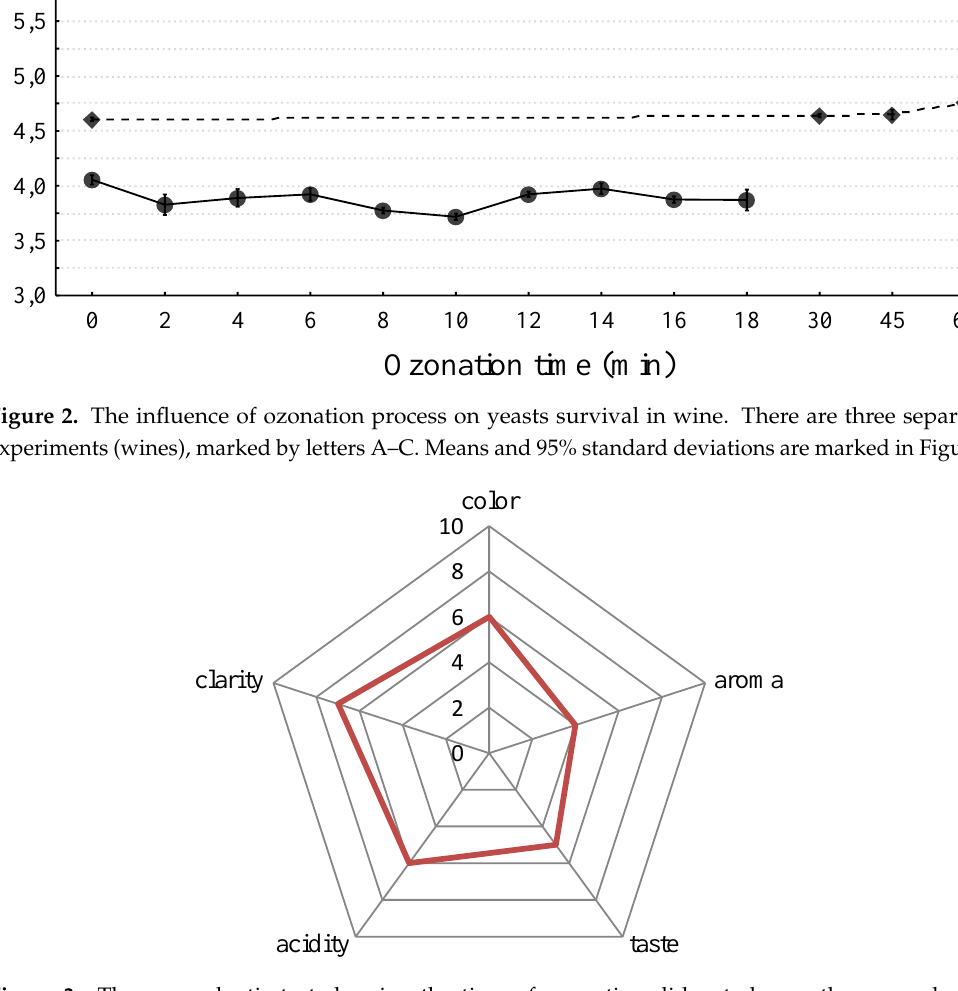
Figure 3. The organoleptic test showing the time of ozonation did not change the organoleptic parameters of the wine (0–10 ozonation time—minute; 0 means control wine—not subject to ozonation. The line indicates the time of ozonation to which no changes in wine parameters were noticed).